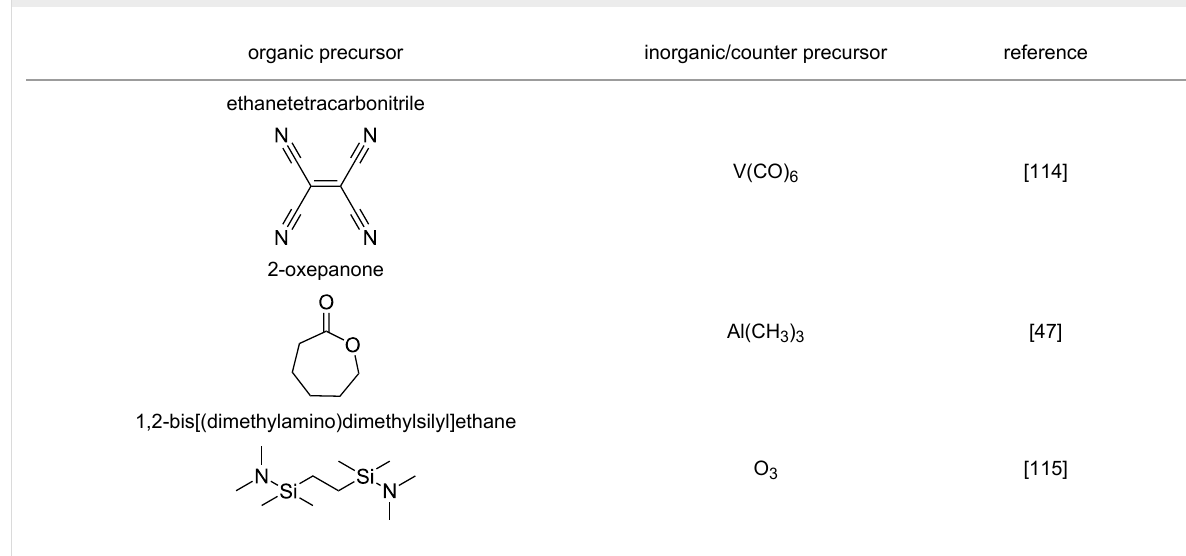
Table 14: Various unclassified organic precursors used to deposit inorganic–organic hybrid thin